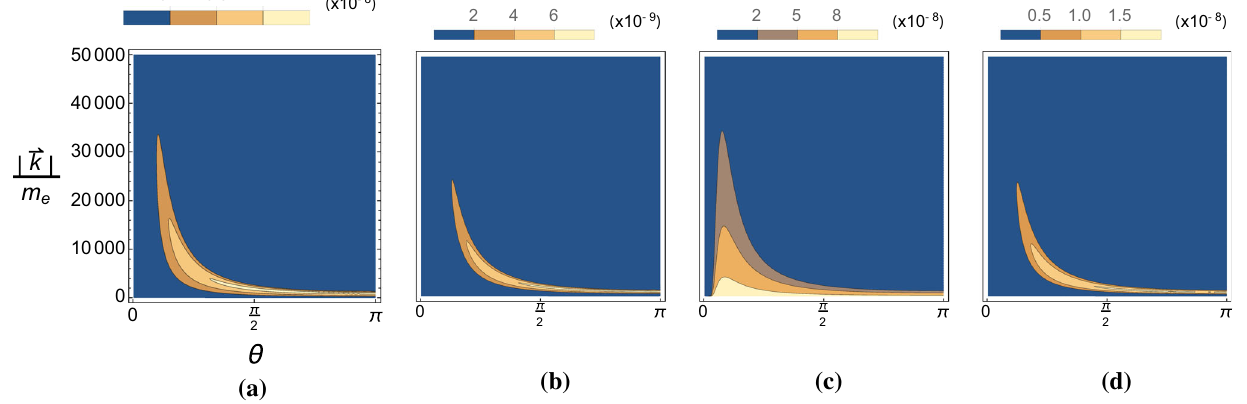
Fig. 12 The pseudo-scalar (left) and scalar (right) yields, P ± , are plotted as a function of the χ k /χ p and the phase ϕ ∗ in a Gaussian background for two different ALP masses. Also, χ p , 0 has been fixed to 1. a P − , δ = 0, b P − , δ = 0 . 6, c P + , δ = 0, d P + , δ = 0 . 6 0.4 0.8 1.2